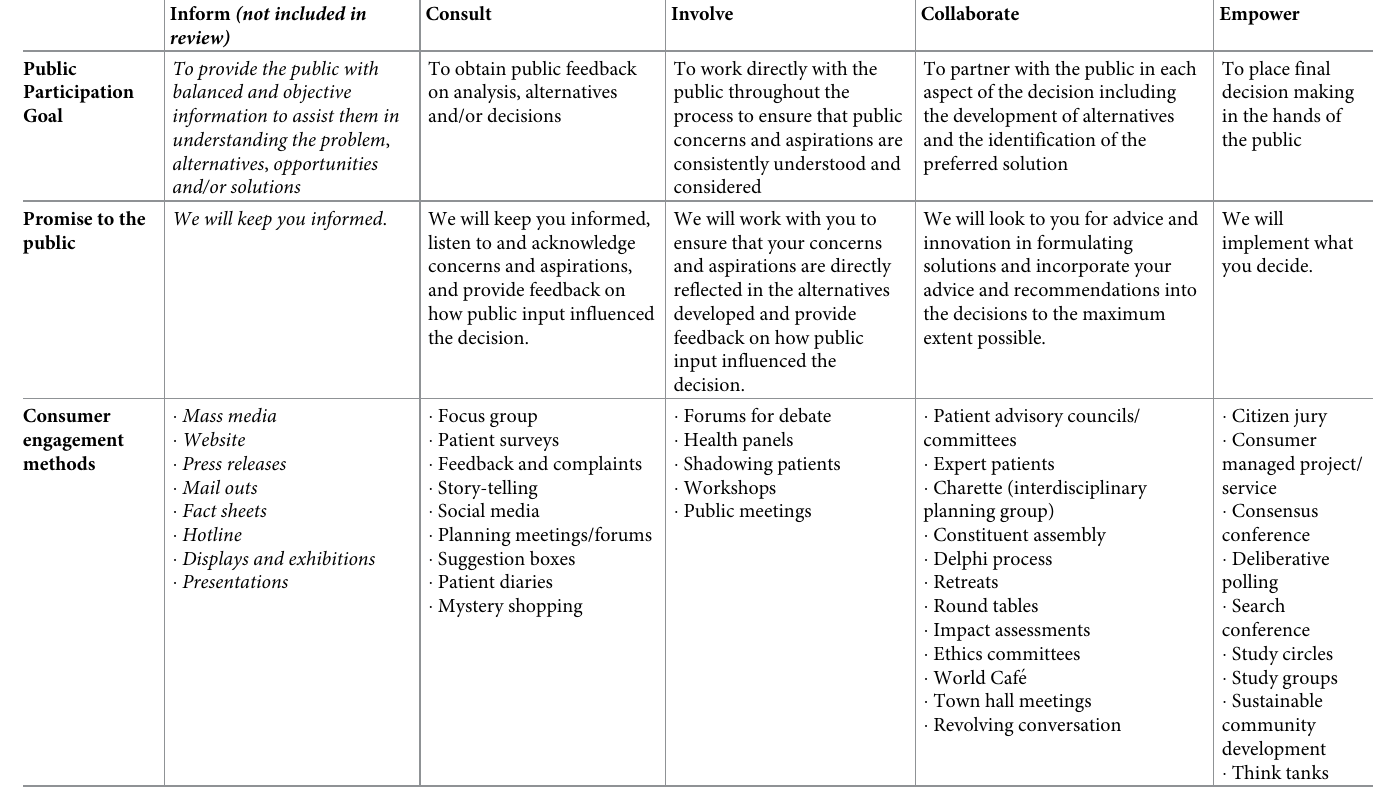
Table 1. Interventions with consumer engagement as defined by the IAP2 Public Participation Spectrum. Inform (not included in review)